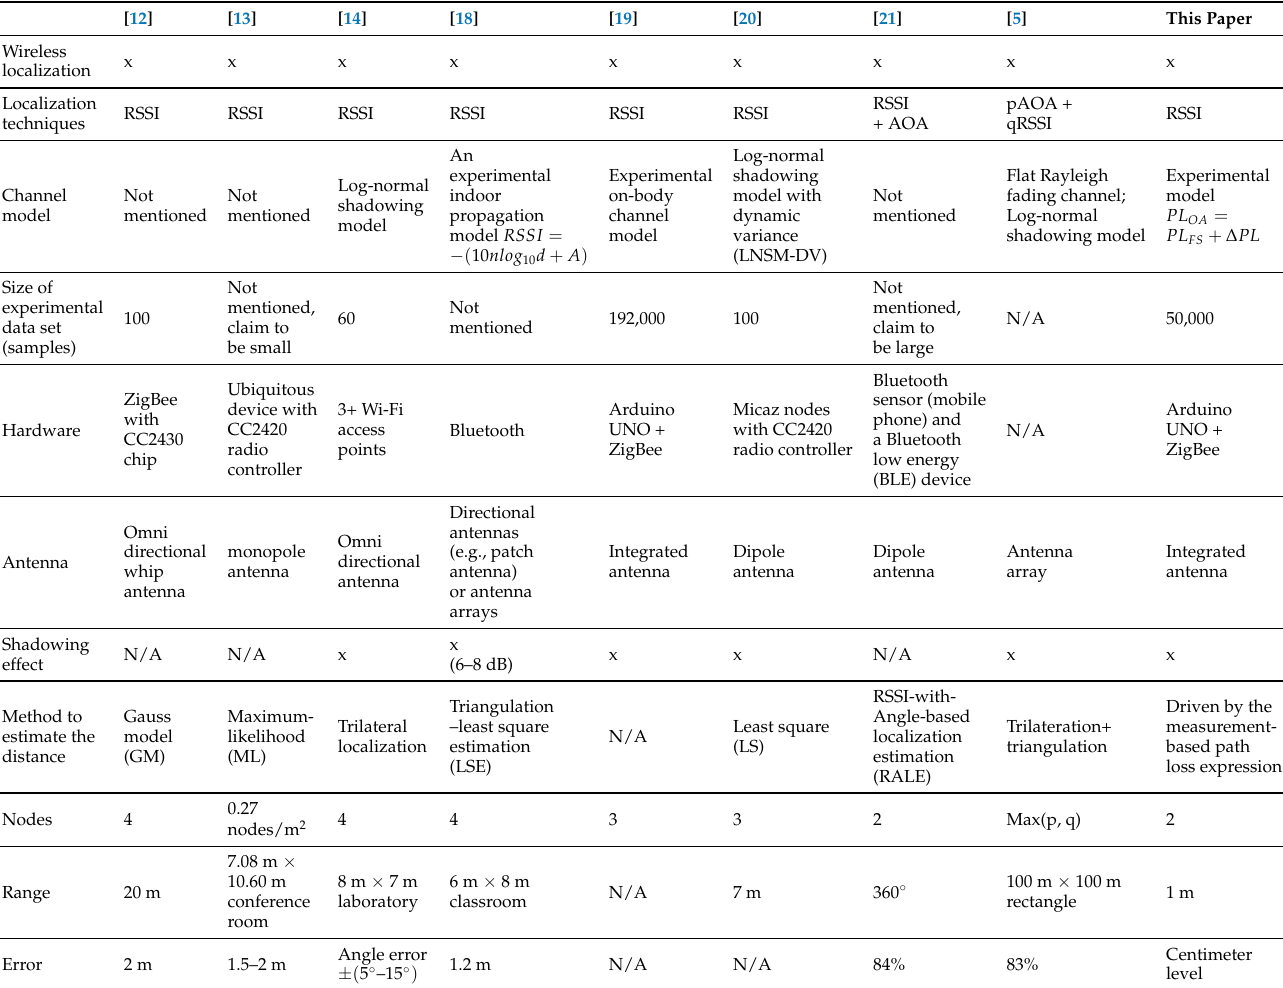
Table 1. Comparison between various research works focused on the Received Signal Strength Indicator (RSSI) method of distance